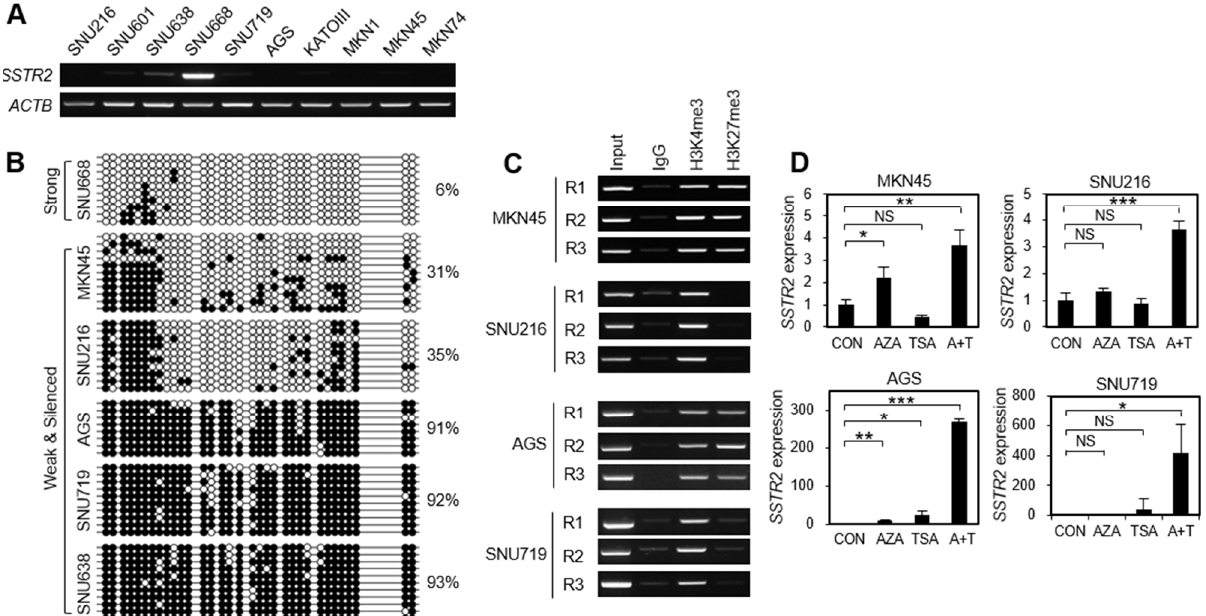
Figure 3. Promoter methylation and expression for SSTR2 in GC cell lines. ( A ) RT-PCR analysis in 10 GC cell lines. ACTB was used as an internal control. ( B ) Bisulfite sequencing analysis for promoter regions of SSTR2 gene. It was analyzed according to the same procedure of Figure 2B. Six GC cell lines were categorized into two groups (one Strong and five Weak and Silenced) based on level of SSTR2 expression by RT-PCR analysis. ( C ) ChIP-PCR analysis at the promoter regions of SSTR2 . Three regions were selected for this analysis: region 1 ( − 654 to − 491 from TSS), region 2 ( − 69 to +124), and regions 3 (+244 to +421). H3K4me3 and H3K27me3 were used as active and repressed markers, respectively. IgG was used as a negative control. ( D ) Restoration of SSTR2 mRNA expression after treatment with 5-aza-dC (AZA) and/or trichostatin A (TSA). The expression was examined by RT-qPCR analysis and normalized to ACTB expression in each sample. Each value is the mean (cid:3399) SD of three independent experiments. * p < 0.05, ** p < 0.01, *** p < 0.001 versus untreated (CON) cells. NS, non-significant.